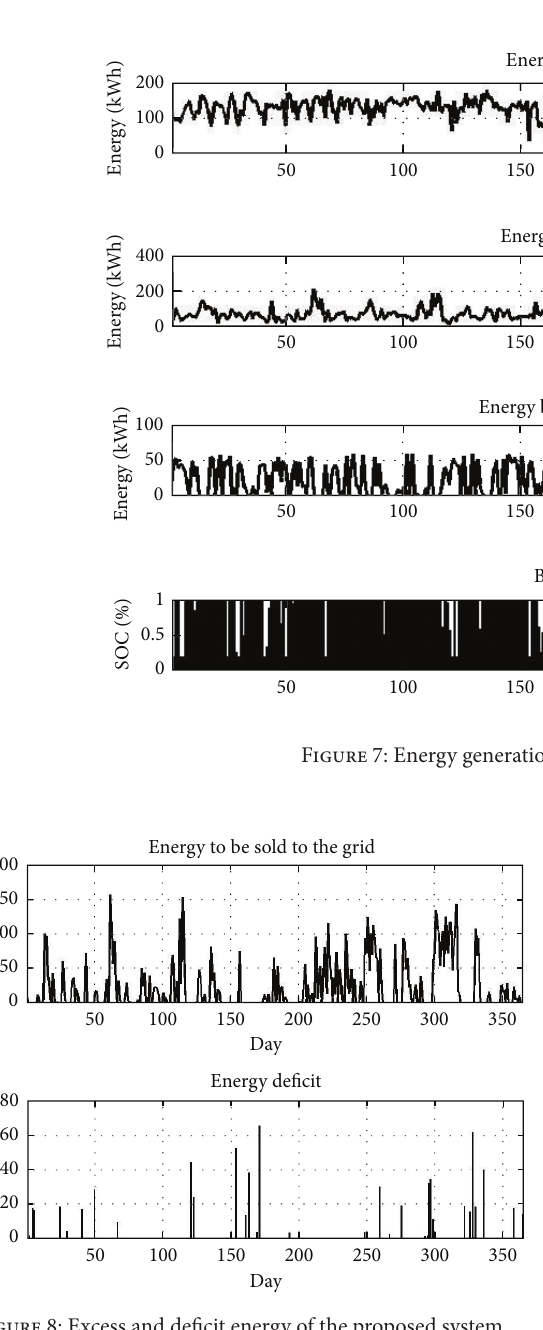
Figure 8: Excess and deficit energy of the proposed